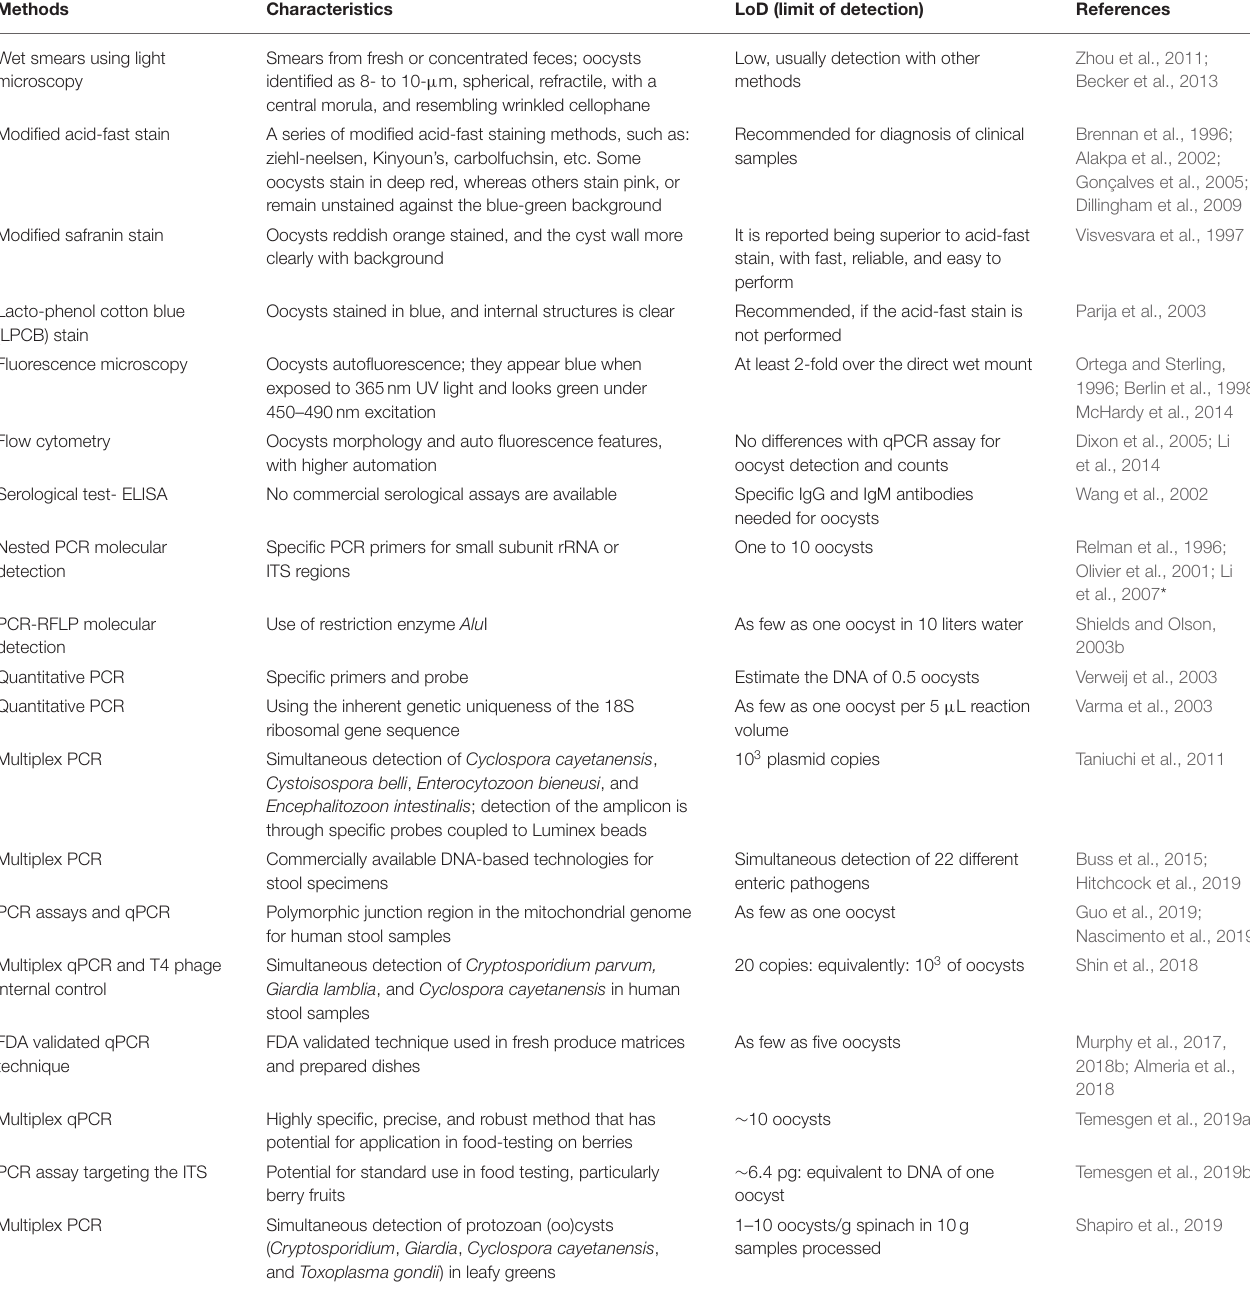
TABLE 1 | Common Cyclospora cayetanensis detection